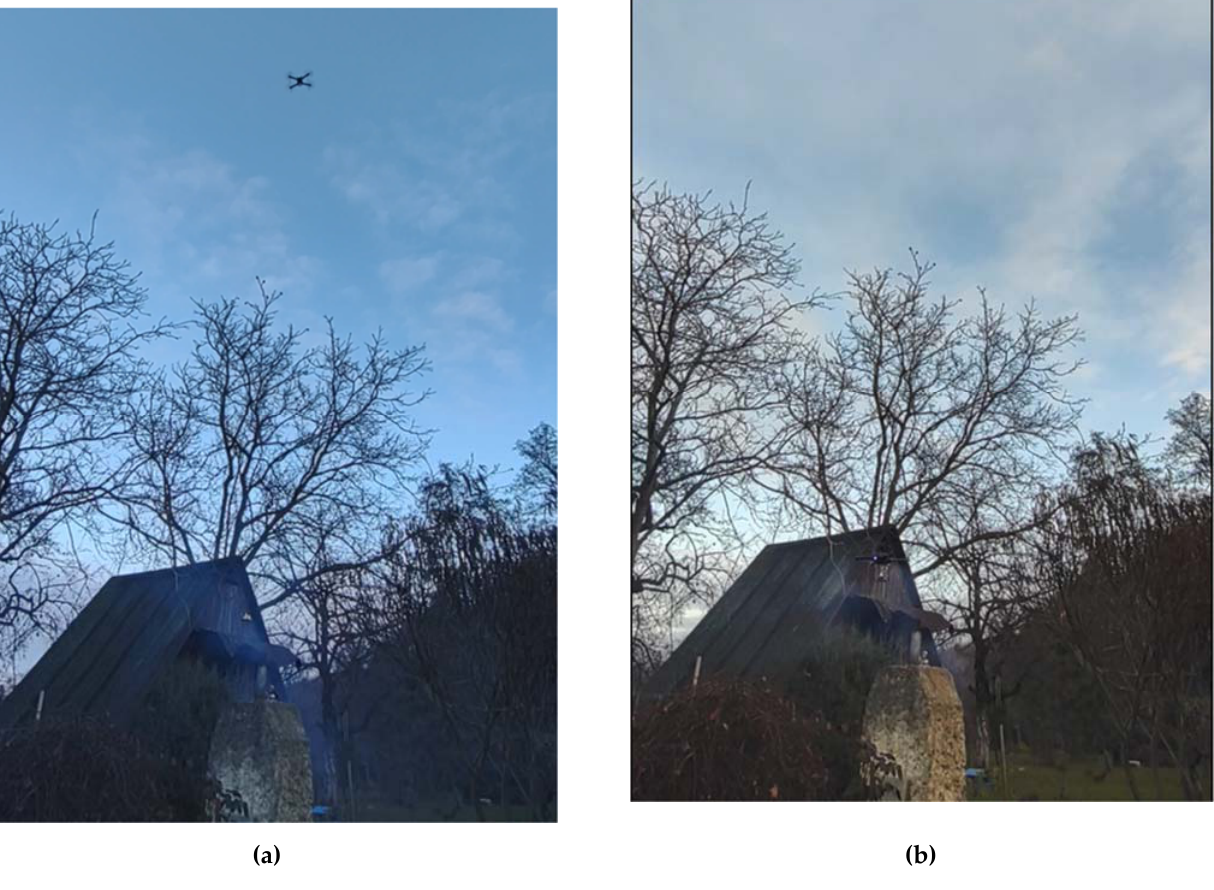
Figure 11. Comparative experiment CE1 (branches burning). The sensing platform was: ( a ) lowered from the drone, ( b ) docked under the drone.